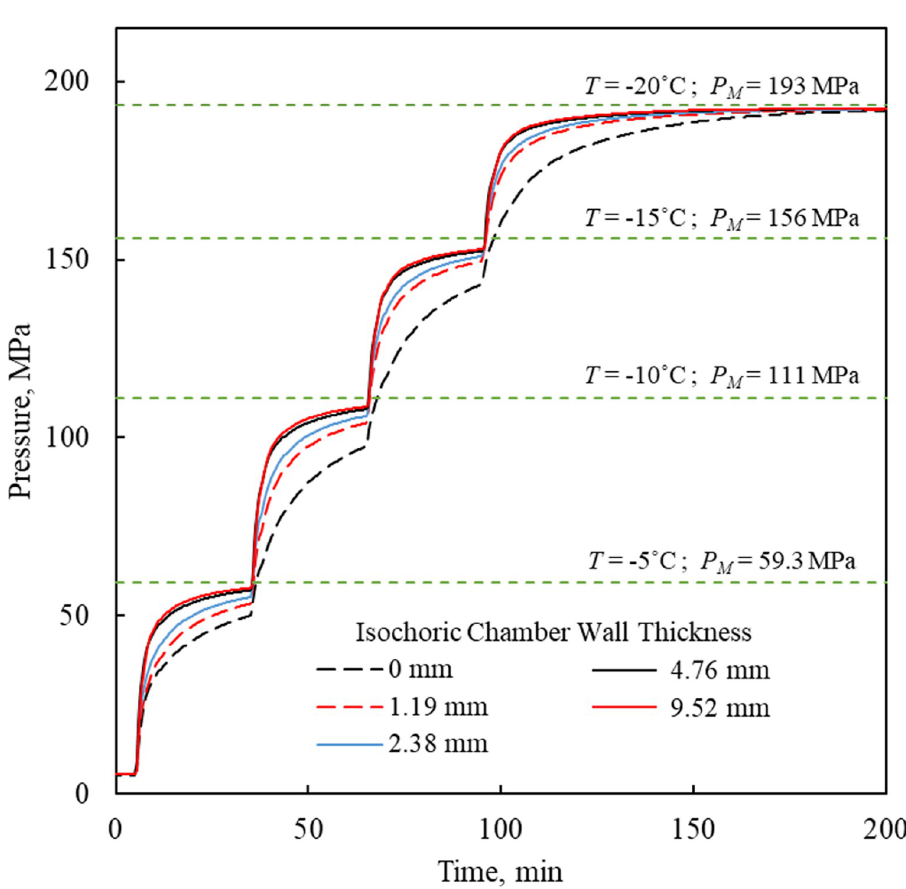
Fig 7. The effect of wall thickness on the temperature-pressure history during isochoric cooling. The analysis is 1D for a geometric model similar to the experimental setup, where the cooling rate between subsequent temperature steps is 20˚C/min while the heat transfer coefficient on the outer surface of the system is 350 W/m 2